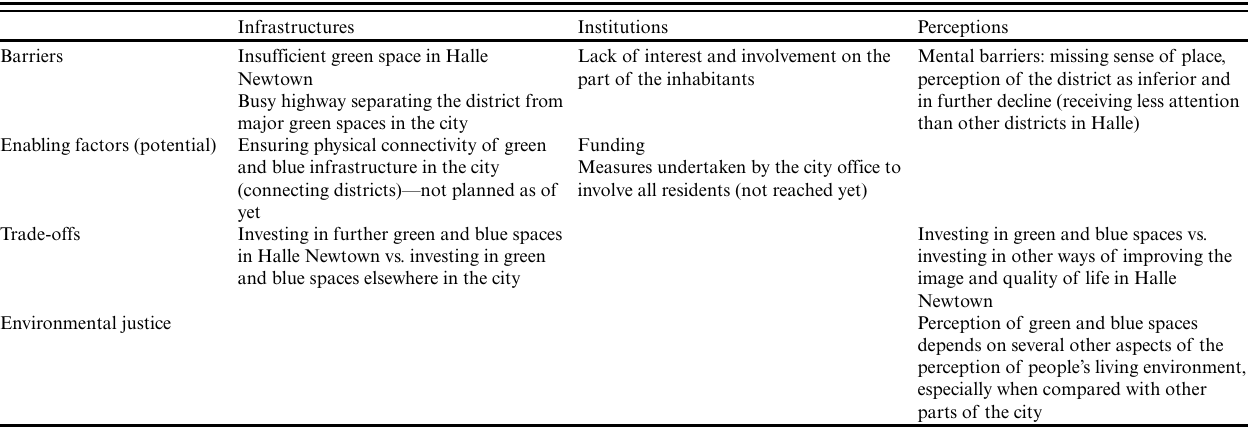
Table 5. . ENABLE filters mediating the flow of benefits from GBI to potential beneficiaries translated into an analytical framework for the assessment of GBI-related initiatives—in the case of greening in Halle Newtown.